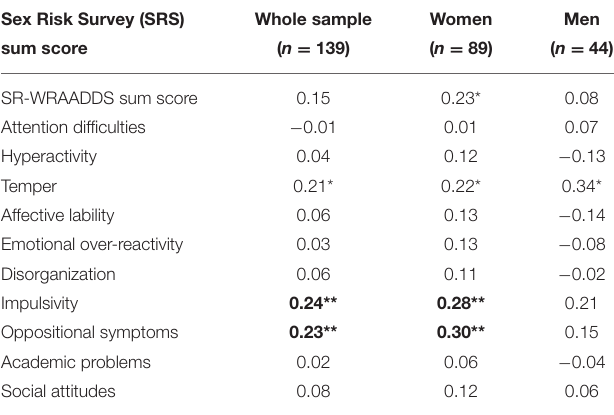
TABLE 7 | Frequency of sexual dysfunctions in men with ADHD compared to men without ADHD using the SBQ-G.